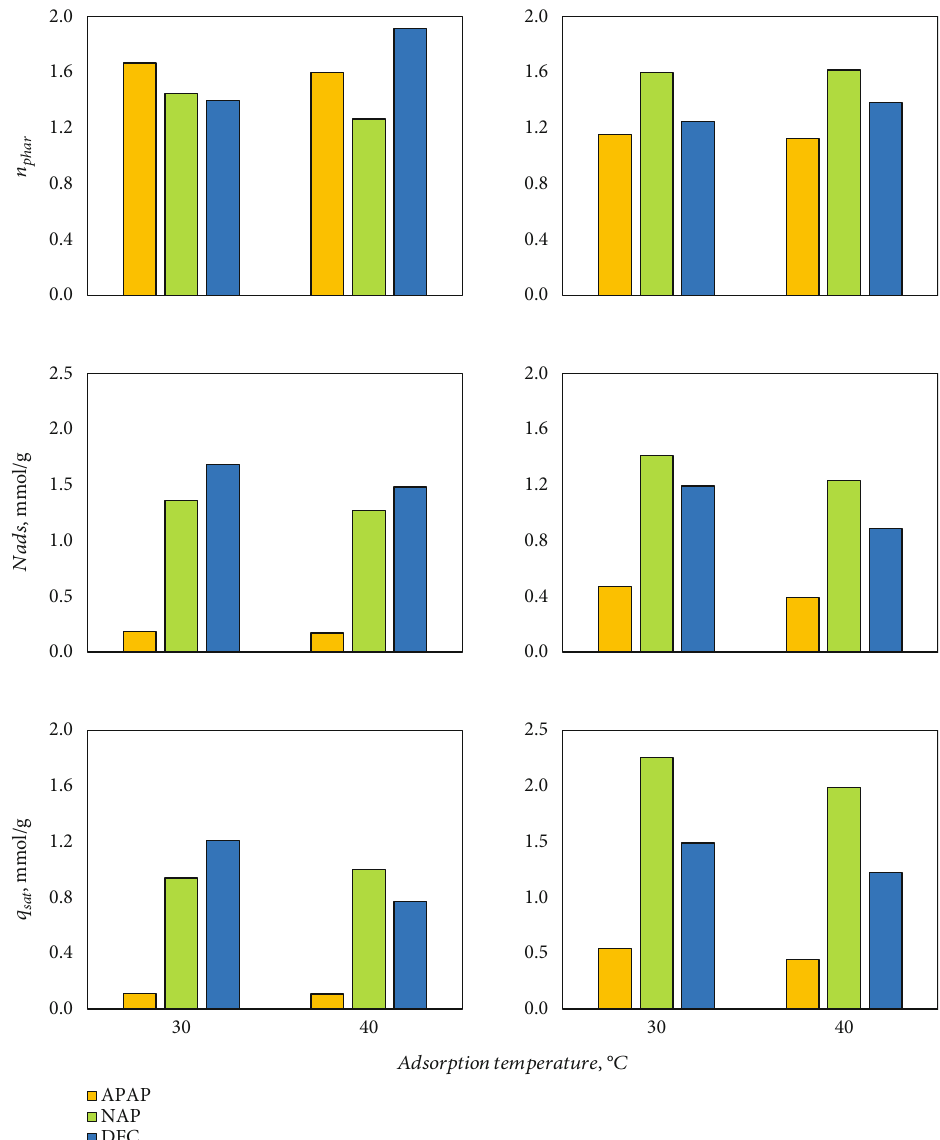
Figure 7: Calculated physicochemical parameters of the adsorption of acetaminophen, diclofenac, and naproxen on MIL-100-Fe and MIL- 101-Fe from aqueous solution at pH